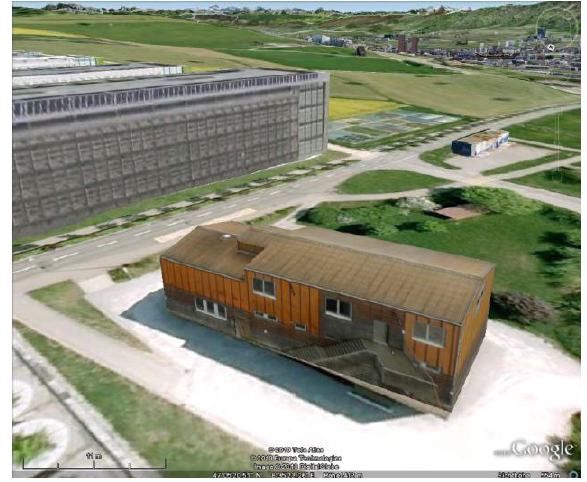
Figure 13 . 3D-Model derived from UAV images of the HXE- building at Campus Science City ETH Hoenggerberg, imported to Google